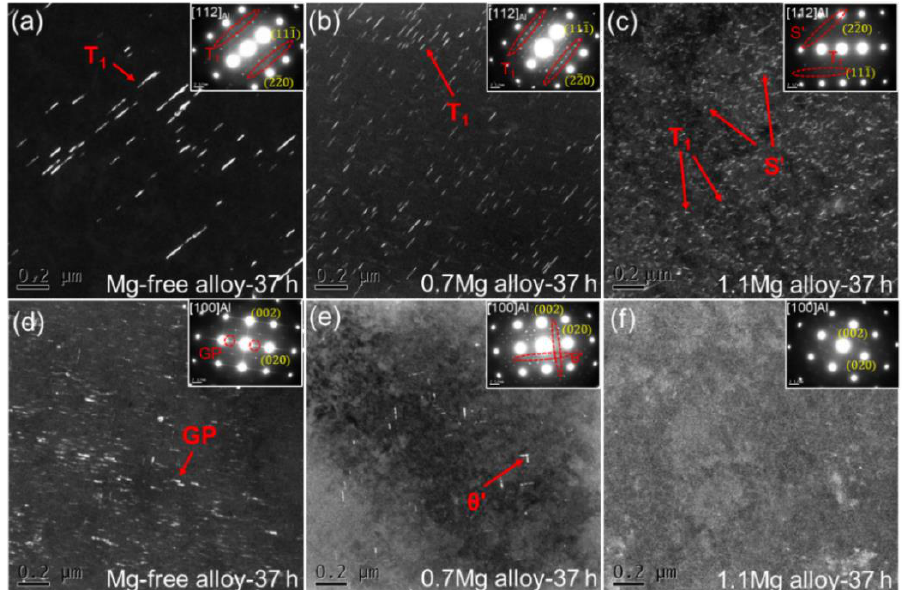
Figure 6. DF TEM images and corresponding SAED patterns for Al–Cu–Li alloys with different Mg content (Mg-free alloy ( a , d ), 0.7Mg alloy ( b , e ), 1.1Mg alloy ( c , f )) aged at 150 ◦ C for 37 h. DF TEM images and corresponding SAED patterns for Al–Cu–Li alloys with different Mg content aged at 150 ◦ C for 97 h are displayed in Figure 7. The SAED patterns along <112> Al for Al–Cu–Li alloys with various Mg content show the existence of T 1 precipitates. There are few T 1 precipitates in the Mg-free alloy aged at 150 ◦ C for 97 h (Figure 7a), which is similar with the Mg-free alloy aged at 150 ◦ C for 37 h. It is worth mentioning that a substantial number of fine T 1 precipitates can be seen in the 0.7Mg alloy (Figure 7b) while there are coarser T 1 precipitates in the 1.1Mg alloy (Figure 7c), with a minor number of the S (cid:48) precipitates present as well. When Mg is added in the proper quantity, the T 1 precipitates are accelerated while θ (cid:48) precipitates are inhibited.